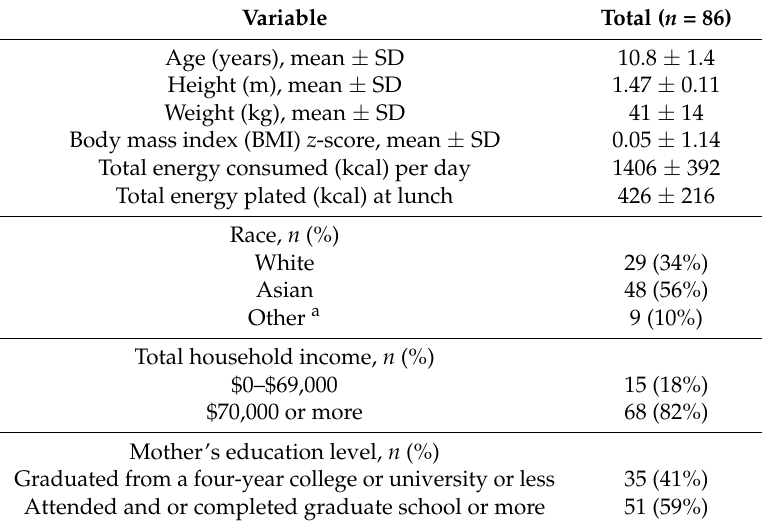
Table 1. Characteristics of 86 girls nine to thirteen years living in O’ahu, Hawai’i who participated in the study and completed an acceptable mobile food record.